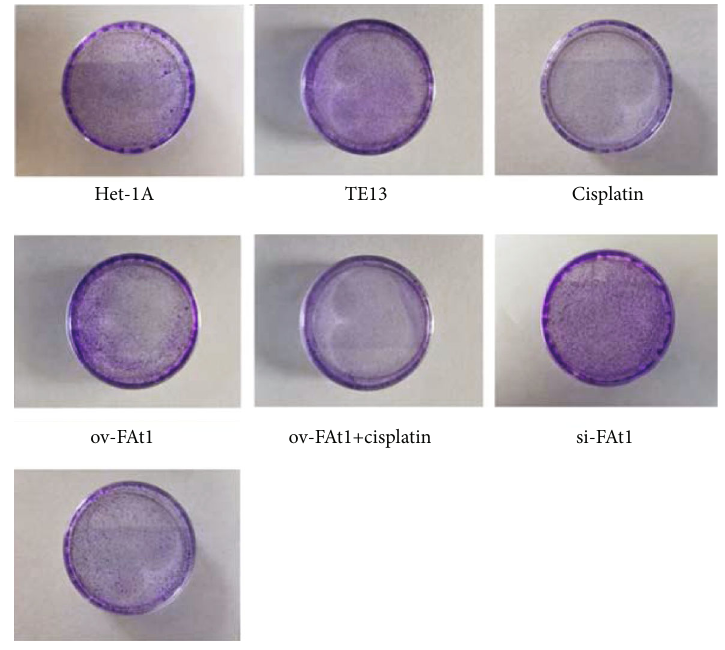
Figure 4: FAT1 inhibits the cell viability of human esophageal cancer cell lines. Clone formation assay was used to detect the proliferation ability of cells in each experimental group (het-1A cell line, TE13 cell line, TE13 cells treated with cisplatin, and TE13 cells transfected with ov-FAT1 and si-FAT or treated with cisplatin at the same time). The clones were fi xed and stained using Crystal Violet.